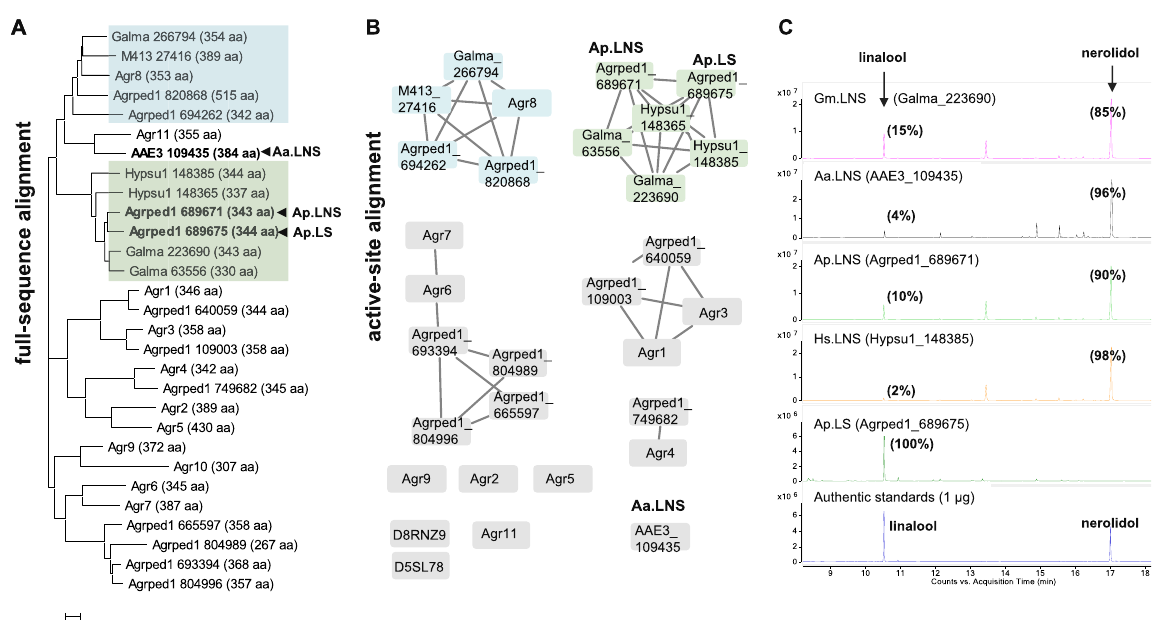
Fig. 3 Sequence analysis of fungal TPS homologs. A Phylogenetic tree based on full-sequence alignment consisting of 12 TPS homologs from A. aegerita (Aa.LNS and Agr), 11 from A. pediades (Ap.LS, Ap.LNS and Agrped1), 3 from Galerina marginata (Galma), 2 from Hypholoma sublateritium (Hypsu1), and 1 from Hebeloma cylindrosporum (M413_27416). B Sequence similarity network (SSN) built on the predicted active sites (Supplementary Table S1). Agr10 is excluded as it shares limited similarity to the templates (PDB ID: 4LXM and 5NX5). Instead, D5SL78 from Streptomyces clavuligerus and D8RNZ9 from Selaginella moellendorf fi i (Spikemoss) are included. The rest of the candidates are the same as those of full-sequence alignment. LNS and muurolene/ cadinene synthase groups are highlighted in green and blue, respectively. C Experimental validation of the predicted fungal TPS homologs. Ap.LS produced exclusively linalool; the other four produced both nerolidol (85 – 98%) and linalool (15 – 2%). Here percentage (%) refers to the peak area ratios of linalool or nerolidol to the sum of the peak areas of both substances present in each